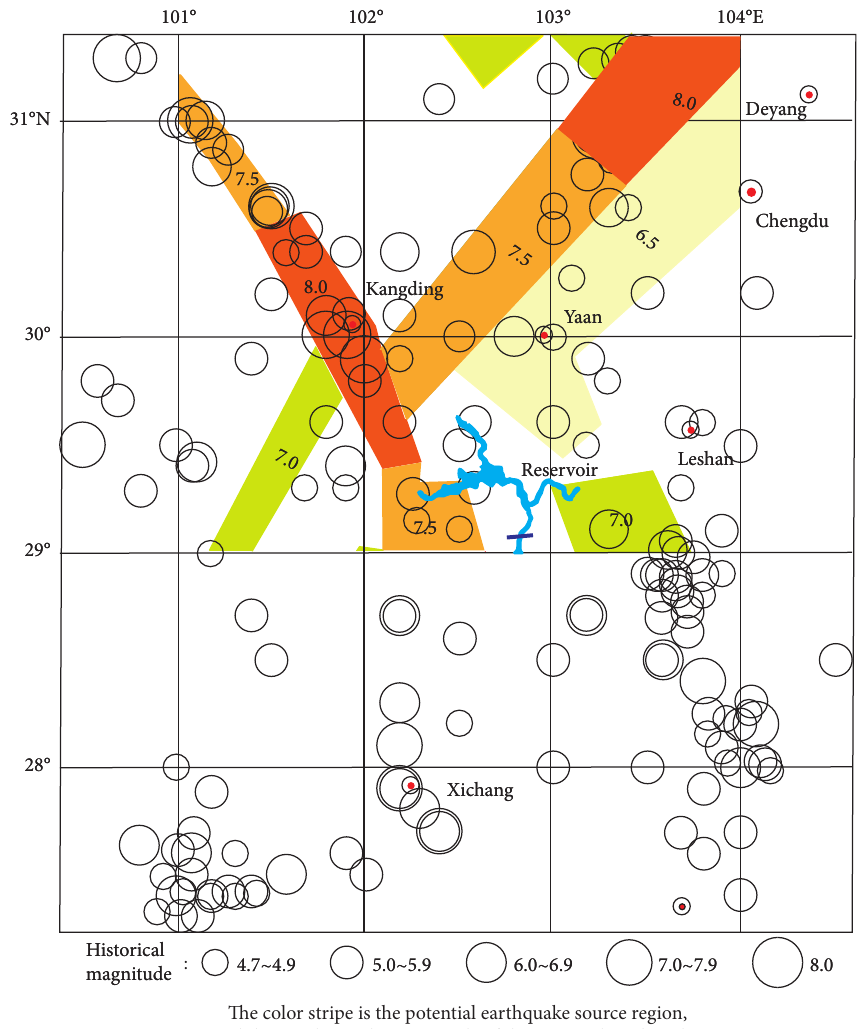
The color stripe is the potential earthquake source region, and the number is the magnitude of the potential Figure 5: The historical earthquakes around the PBG hydropower station.